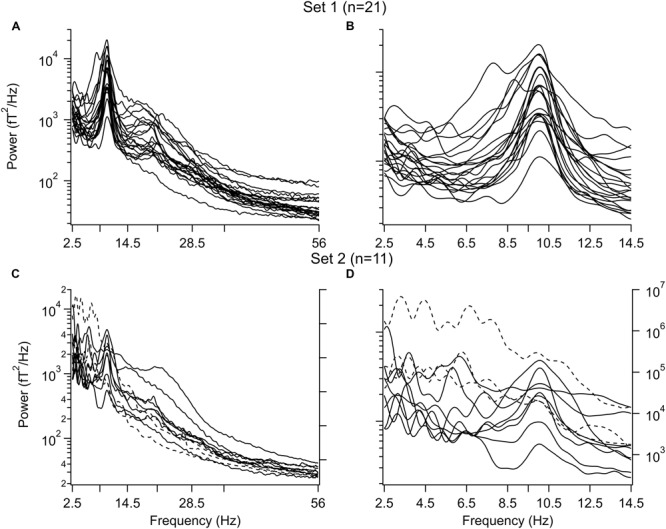
Power spectra before 1-octanol. (A,B) Subjects with a dominant alpha peak and without peaks in the delta and/or theta frequency band. (A) Entire spectrum from 2.5 to 56 Hz. (B) Same as in A for 2.5–14.5 Hz. (C,D) Subjects with peaks in the delta and/or theta frequency band. (C) Entire range. (D) Same as in C for 2.5–14.5 Hz. Note variation in waveforms. Three subjects in (C,D) had a larger power than the other subjects and use the power scale on the right (broken lines). Peaks were aligned to the individual alpha frequency (IAF) for each subject. This value was set to 10 Hz